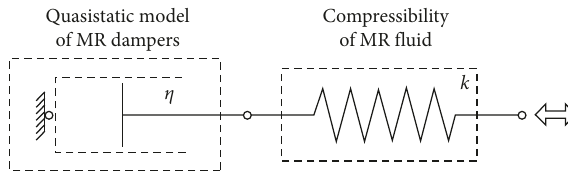
Figure 2: A physical model of MR